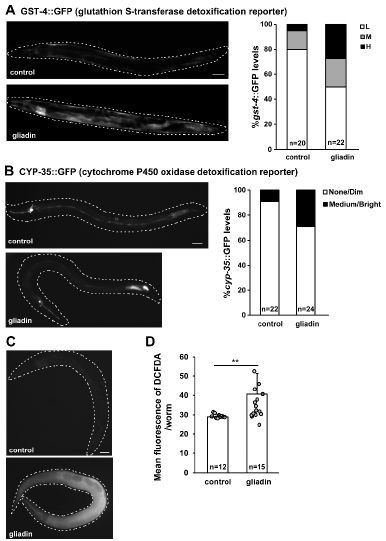
Figure 1. Gliadin intake-induced glutathione S-transferase 4 (GST-4), cytochrome P450 oxidase (CYP-35), and reactive oxygen species (ROS) production in adult-stage Caenorhabditis elegans worms. ( A ) Pgst-4::GFP transgenic populations synchronized at the L4 larval stage were treated with gliadin for 24 h at 20 °C. Pictures show representative images of Pgst-4::GFP expression after 24 h of gliadin treatment. The bar graph (right panel) shows quantified induction levels of the Pgst-4::GFP reporter in the intestine categorized as low (L), medium (M), and high (H) based on a previously established scale [31]. Scale bar, 100 µm. ( B ) cyp-35::GFP transgenic populations synchronized at the L4 larval stage were treated with gliadin for 24 h at 20 °C. Pictures show representative images of cyp-35::GFP expression after 24 h of gliadin treatment. The bar graph shows the distribution of GFP expression levels after gliadin treatments. Scale bar, 100 µm. ( C ) Wild-type N2 animal populations synchronized at the L4 larval stage were treated with gliadin or left untreated as controls. ROS production was measured by 2 ′ ,7 ′ -dichlorodihydrofluorescein diacetate (DCFDA) staining after 24 h of treatment. Pictures show representative images of ROS production after treatment as visualized by DCFDA staining (left panels). ( D ) Bar graph showing pixel intensities from DCFDA fluorescence per worm. Error bars represent s.d. ** p < 0.005 (Student’s t